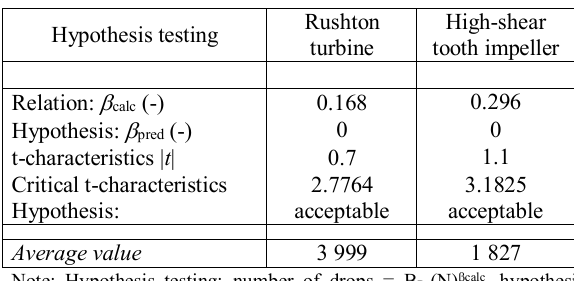
Table 7. Minimum number of drops for evaluation –